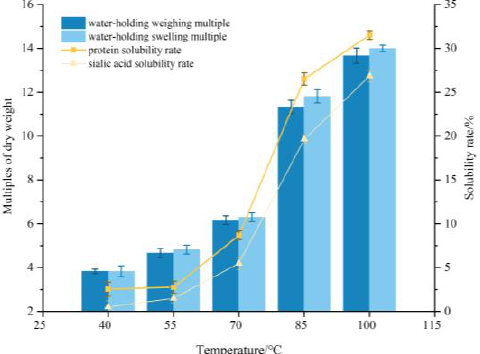
Figure 1. Influence of temperature on water-holding capacity and solubility of edible bird ’ s nest. *.